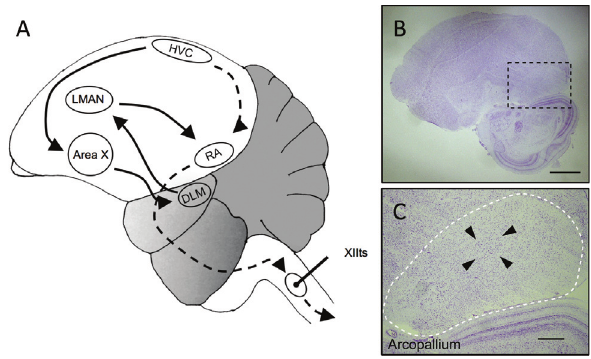
Figure 1 - The song control system of the Pale-breasted Thrush, Turdus leucomelas . (A) Schematic representation of the song control system in an oscine brain, showing the song production pathway (dashed arrows) and the song learning pathway (arrows) (Adapted from Nottebohm, 2005). (B) Nissl stained brain section of T. leucomelas , the arcopallium is located within the dashed line box. (C) The archopallium is demarcated by white dashed line, with arrowheads indicating the location of the RA